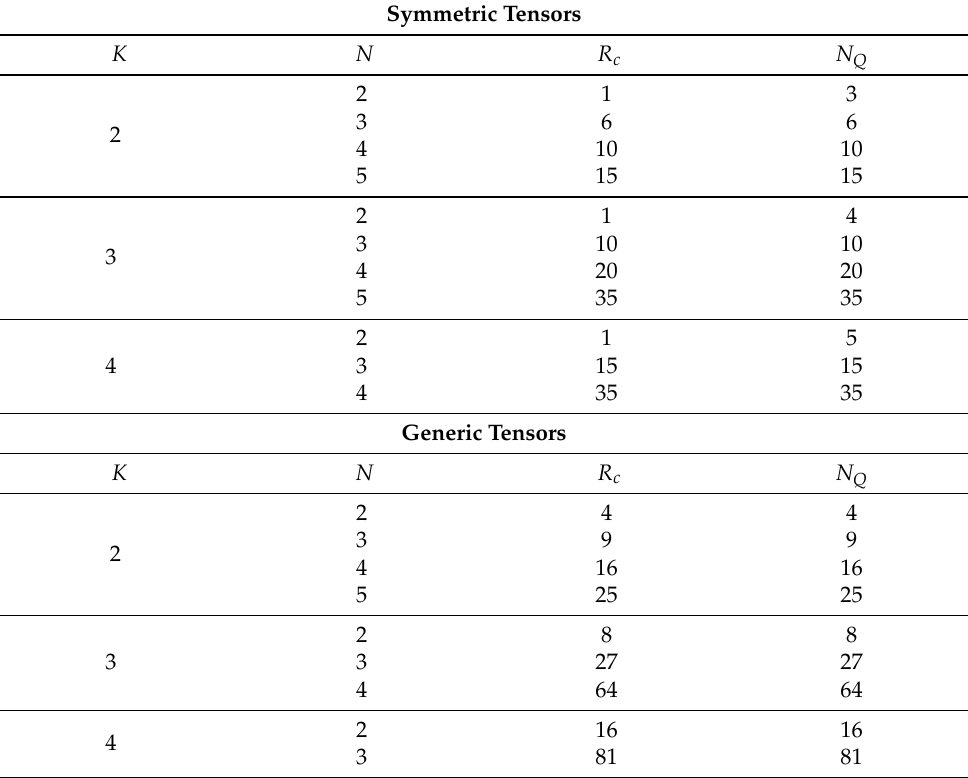
Table 1. The results of the verification of R c for both symmetric tensors and generic tensors. It can be seen that in most cases, except N = 2 for symmetric tensors, the hypothesis R c = N Q holds. Symmetric Tensors K